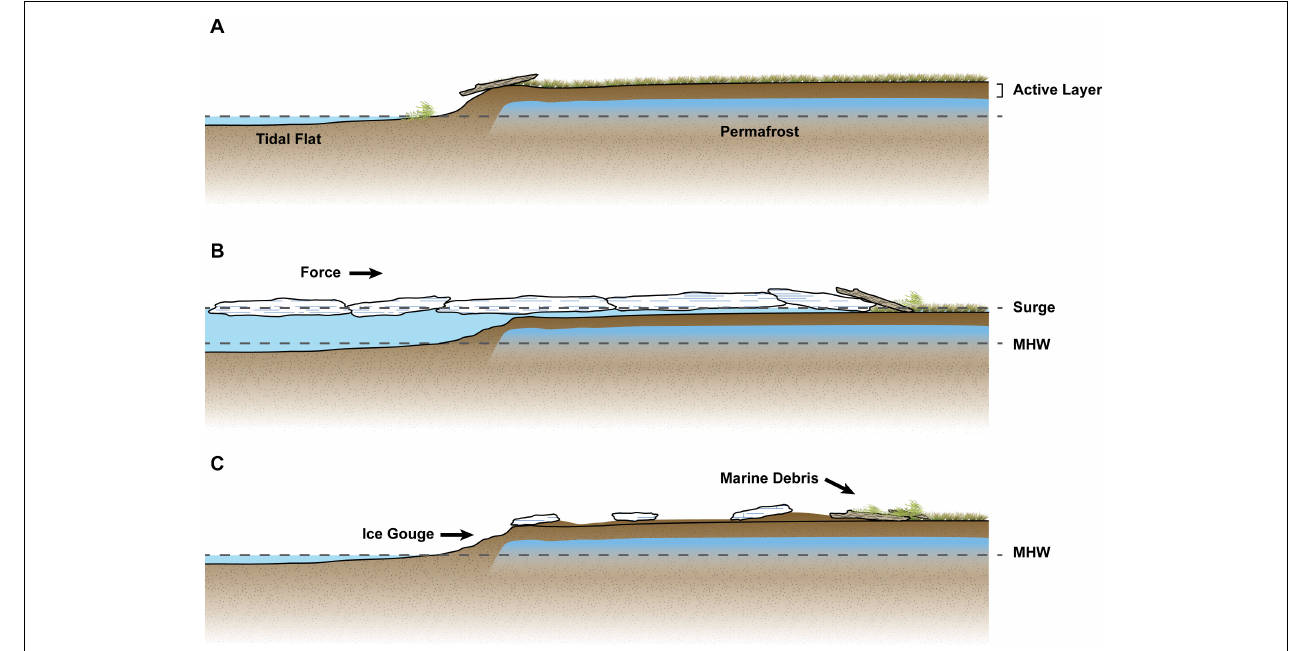
FIGURE 9 | Conceptual diagram showing the before (A) , during (B) , and after (C) cross-sections of the Central portion of coastline ( Figure 3 ). Key features are annotated with the arrows. (A) Undisturbed coastline prior to the ivu depicting lower elevation trough and marsh. (B) Given the lower elevation of the central area, there was an ice ride-up where ice was floated or pushed inland by the storm surge waters but did not leave the distinct debris piles as observed along the Eastern and Western sections. (C) After the event, a clear wrack line marking the maximum inland extent of the event (130 m). MHW, mean high